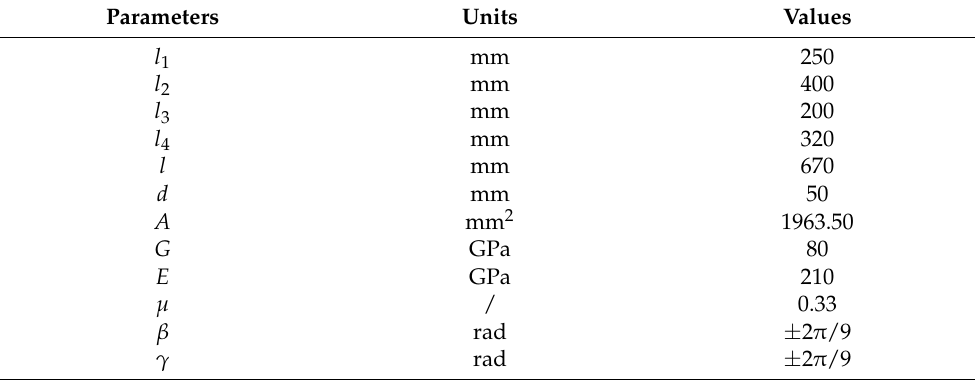
Table 1. Length and material parameters of the redundantly actuated 2UPR–2PRU PM.